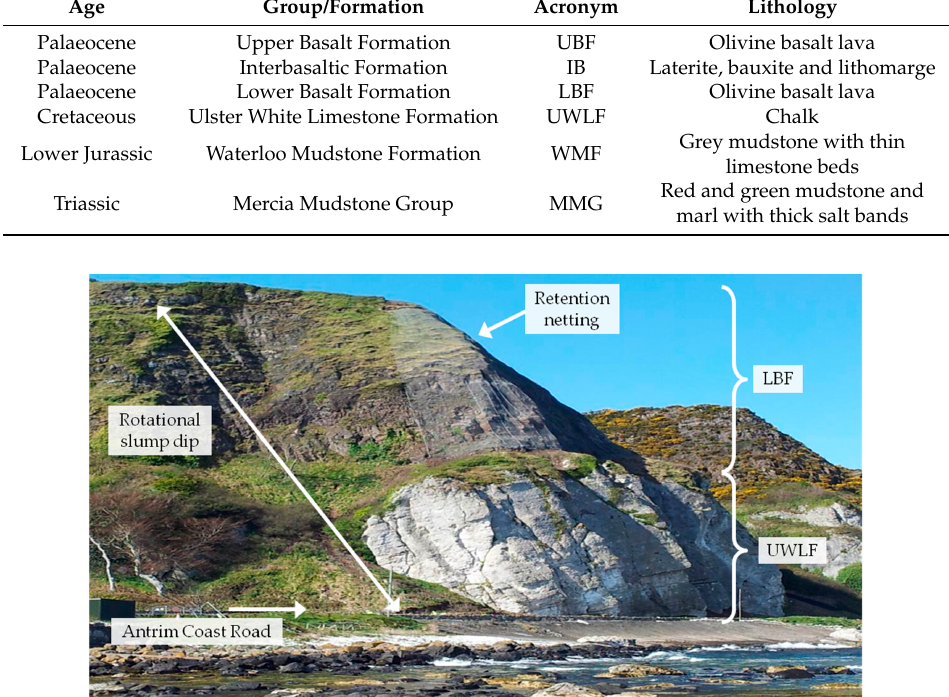
Table 5. Reference summary geology for the Garron Point area.